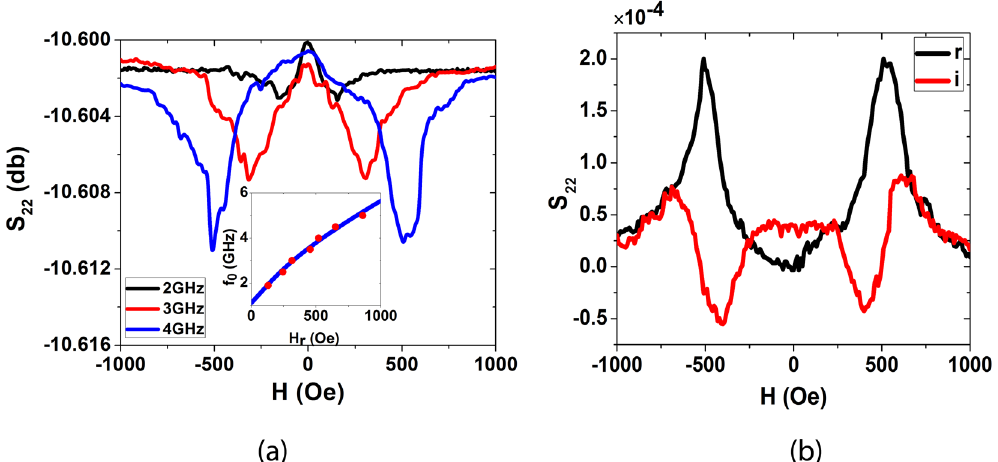
Figure 2. FMR study: ( a ) The FMR signal of the device for different frequencies, the magnetic field was applied at an angle of 45° for this measurement. The inset shows the Kittel’s plot wherein the red points show the experimental data of resonance frequency as a function of magnetic field and the blue curve is obtained from Kittel’s relation. ( b ) The real and the imaginary parts of the S 22 signal for 4 GHz frequency, the black curve marked as ‘r’ and the red curve marked as ‘i’ show the real and imaginary parts